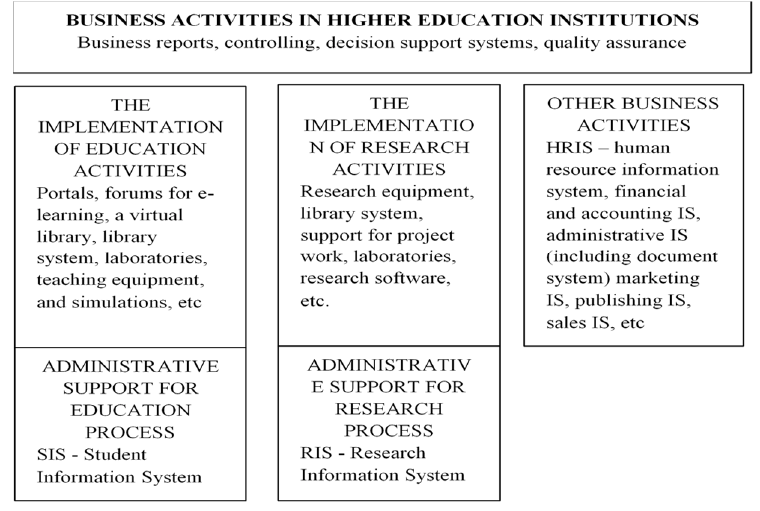
Figure 1. Business activities in a higher educational institution.